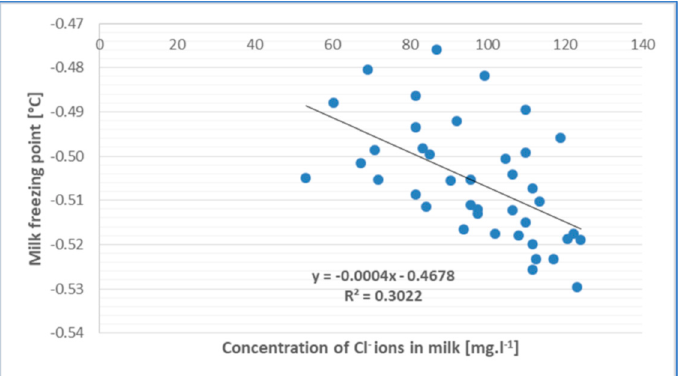
Figure 3. Correlation relationship and regression line of relationships between Cl − content and freezing temperature of raw cow’s milk in 10 samples from SW Slovakia with added water and various content of added NaCl (80 subsamples). Schemes follow the same formatting.